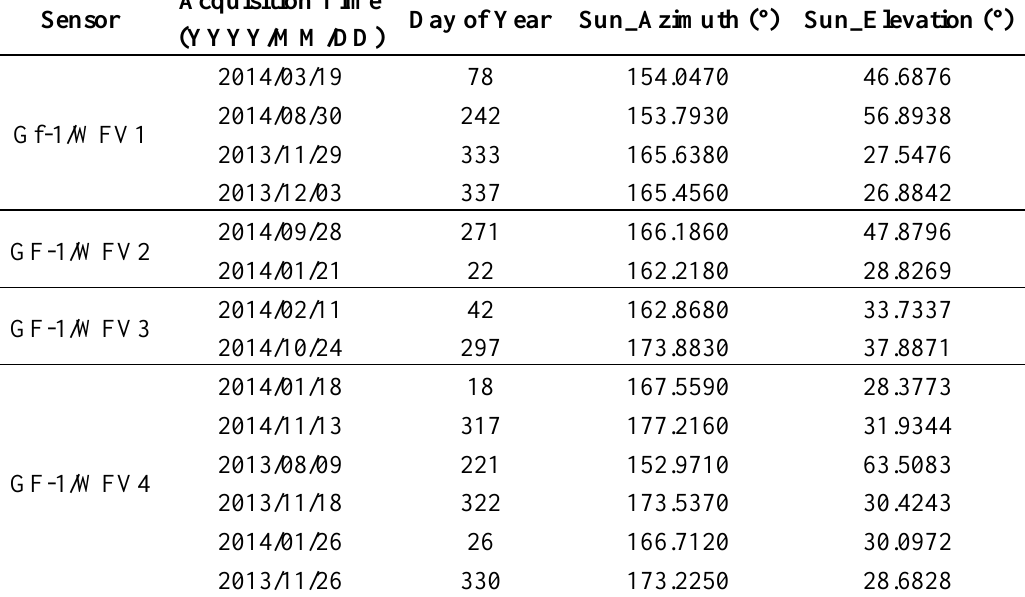
Table 8. Information of selected GF-1/WFVs images.